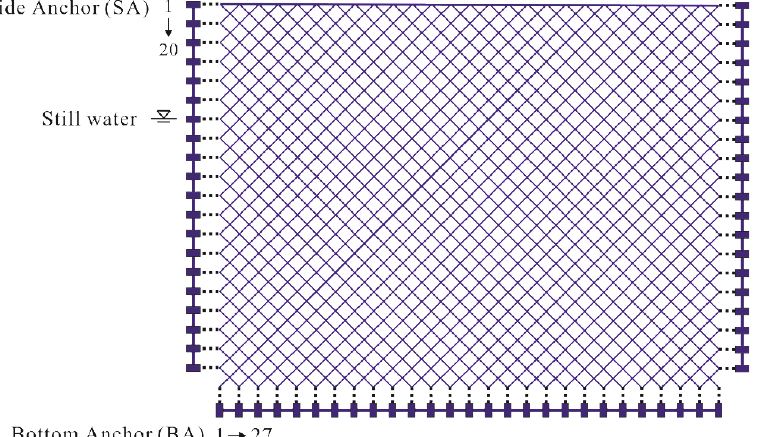
Figure 3. The trash-blocking net and mooring system for the water intake in the NPP.